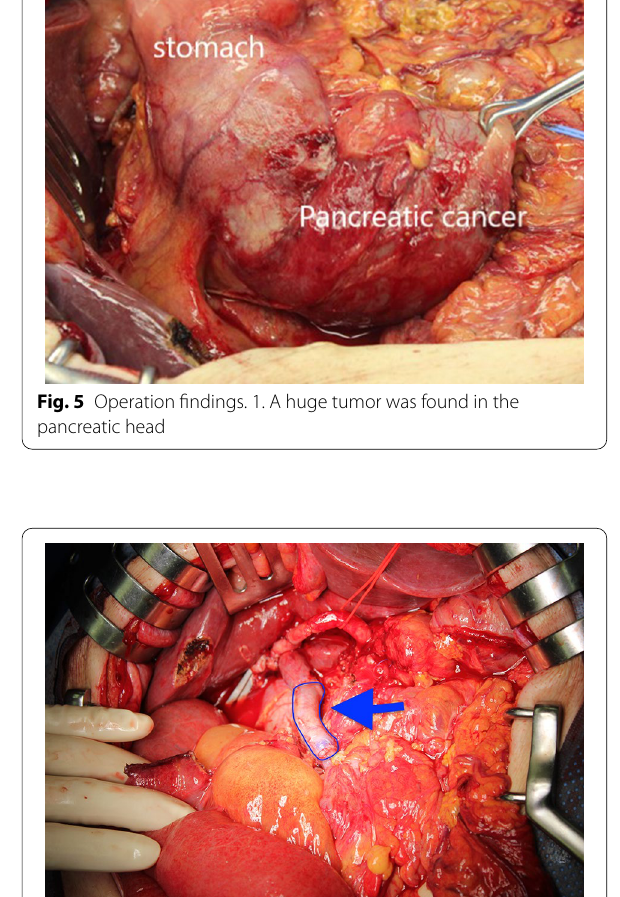
Fig. 6 Operation findings 2. After specimen removal, portal vein reconstruction was performed using a right external iliac vein graft